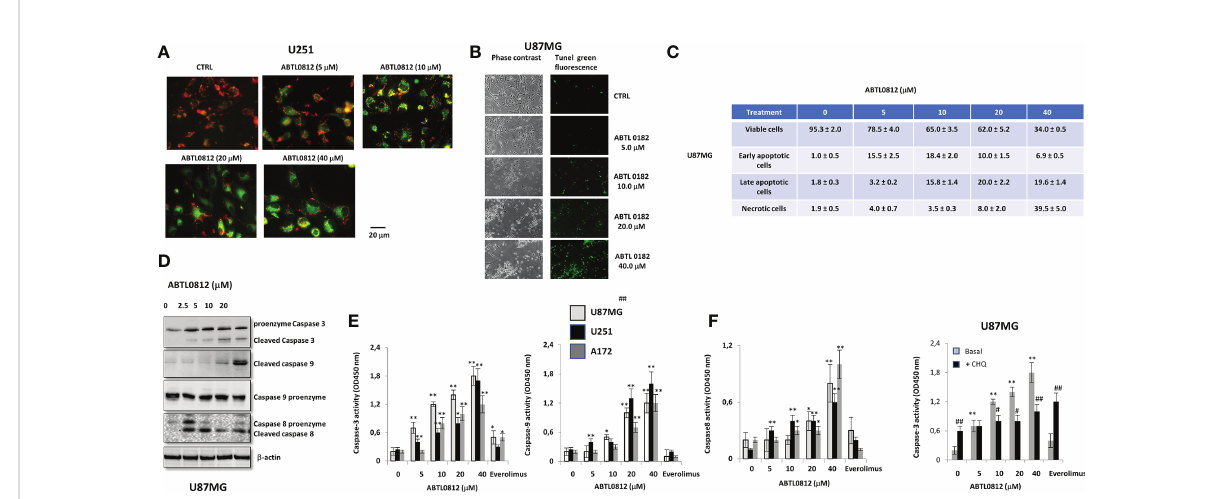
FIGURE 4 ABTL0812 induces mitochondrial depolarization and apoptosis in glioblastoma cells. (A) Representative immuno fl uorescence images of staining with JC-1, a dye indicator of mitochondrial membrane potential in U251MG cells treated for 16 hours with ABTL0812 (200X magni fi cation). Red staining indicates polarized mitochondria and green indicates depolarized mitochondria. (B) Apoptosis TUNEL assay performed on U87MG cells treated with ABTL0812 for 16 hours. (C) Table showing the percentage of cell populations as determined by FACS analysis of annexin V/ propidium iodide staining of U87MG cells treated for 16 hours with ABTL0812. (D) Representative images of immunoblotting detection of caspase 3, 8 and 9 pro-enzymes and cleaved isoforms in U87MG cells treated with ABTL0812 for 16 hours. (E) Quanti fi cation of caspases 8, 9 and 3 activities by using caspase-speci fi c chromogenic substrates in U87MG, A172 and U251 cells treated for 16 hours with ABTL0812. The mTORC1 inhibitor everolimus was used as a comparator to ABTL0812 *p<0.05 and ** p<0.01 vs vehicle treated cells. (F) Quantization of caspase 3 activity in U87MG cells treated for 16 hours with ABTL0812 and with or without a 1 hour chloroquine pretreatment. *p<0.05 and ** p<0.01 vs vehicle basal; # p<0.05 and ## p<0.01 vs